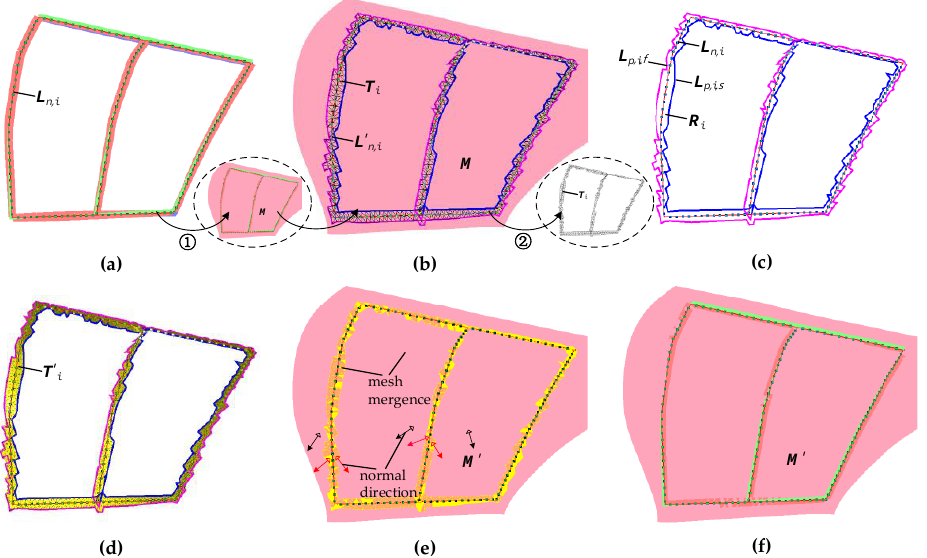
Figure 6. Snapping of non-boundary constraint polylines. ( a ) shows the non-boundary constraint polylines. ( b ) shows the process of projecting constraint polylines onto the model and matching the meshes. ( c ) shows the results of deleting the matched meshes and extracting the boundaries of the projective neighborhoods. ( d ) shows the result of re-meshing the projective neighborhoods. ( e ) shows the results of merging all meshes and unifying the normal direction of all triangular patches. ( f ) shows the mesh model after snapping constraint polylines. ① shows the implicit modeling re- sult. ② shows the matched meshes to be deleted. Figure 7. Snapping of boundary constraint polylines. ( a ) shows the boundary constraint polylines and non-boundary constraint polylines. ( b ) shows the process of projecting constraint polylines onto the model and matching the meshes. ( c ) shows the results of deleting the matched meshes and ex- tracting the boundaries of the projective neighborhoods. ( d ) shows the result of re-meshing the pro-